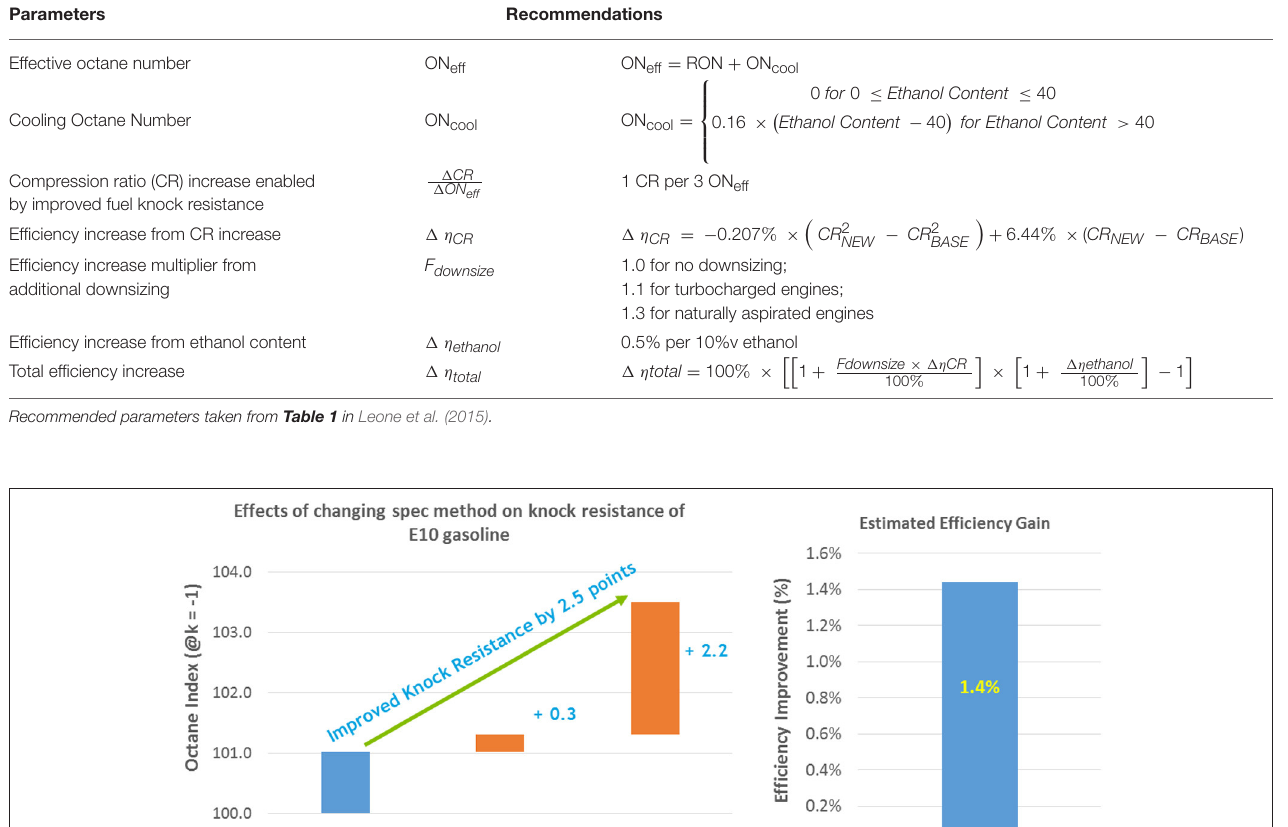
Frontiers in Mechanical Engineering | www.frontiersin.org